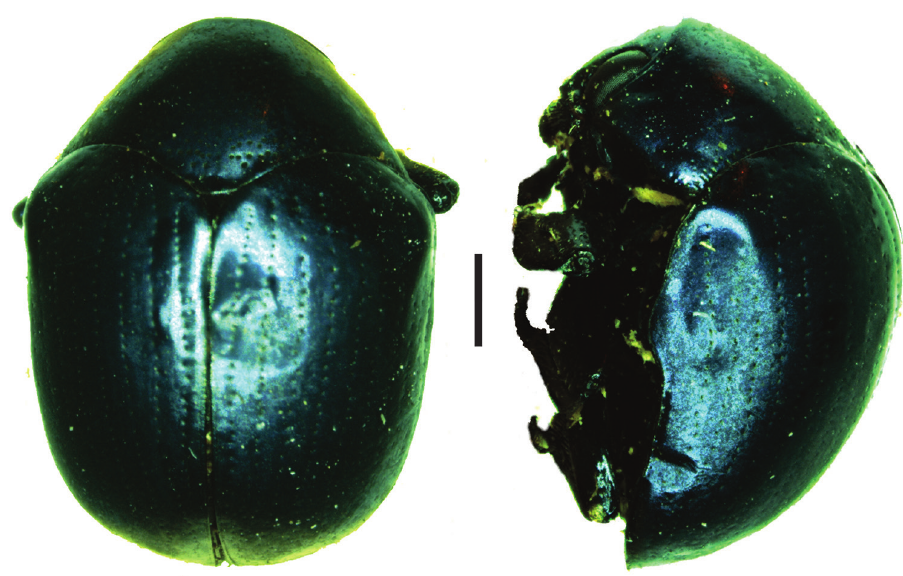
Figure 34. Lamprosoma azureum Germar (3). , left: habitus (dorsal view), right: habitus (lateral view).